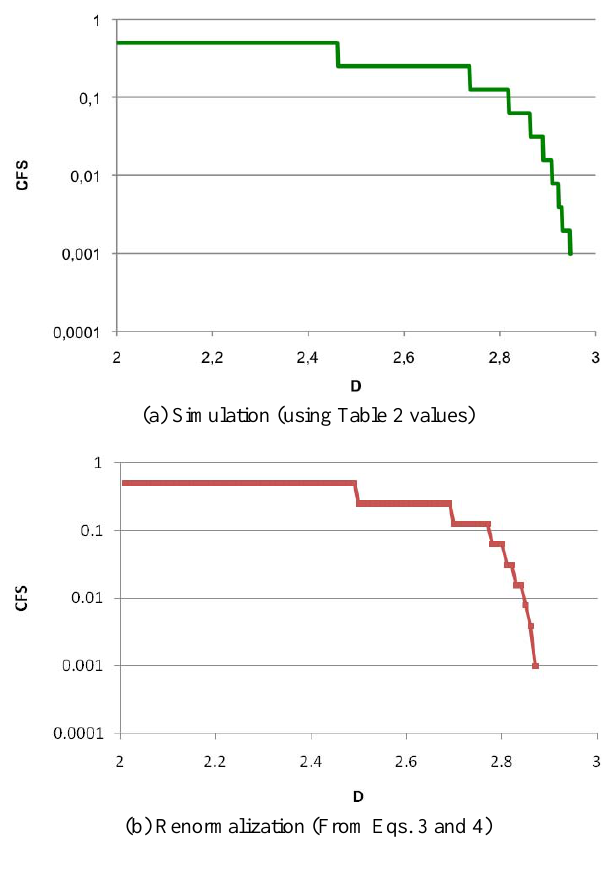
Fig. 4. CFS as a function of D